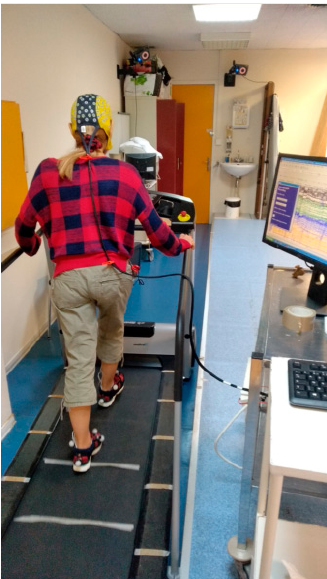
Figure 1. EEG recording during treadmill walking in a healthy subject. The EEG system is synchronized with a video-based motion analysis system (retroreflective markers on both feet) that allows recording of the different events (foot off and strike) characterizing gait. Cortical activity was recorded with an Ag/AgCl 128-scalp-electrode cap (Waveguard®, ANT Neuro, Enschede, The Netherlands). Data were acquired with ASA TM software (ANT Neuro).